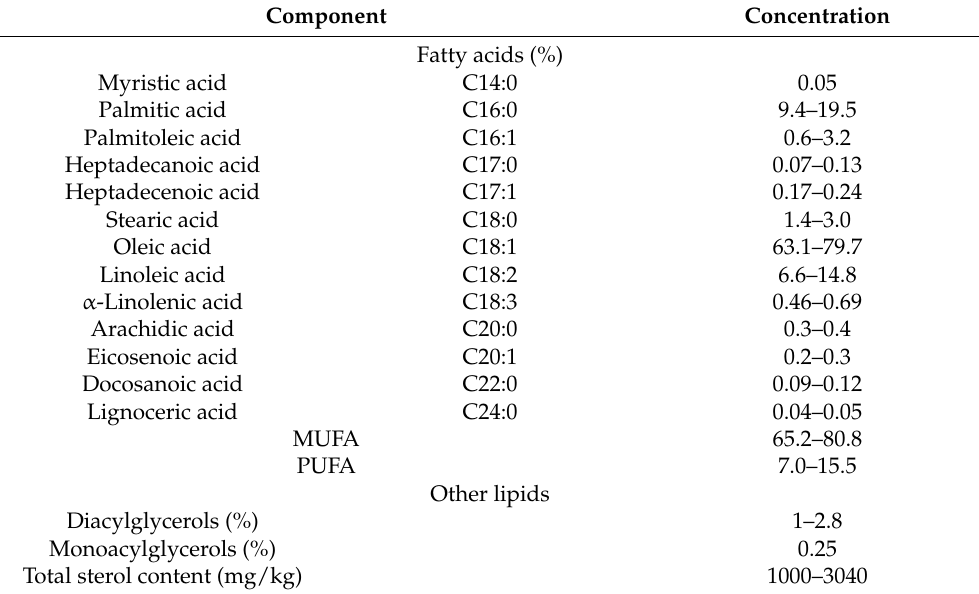
Table 1. Major lipids EVOO components (adapted from